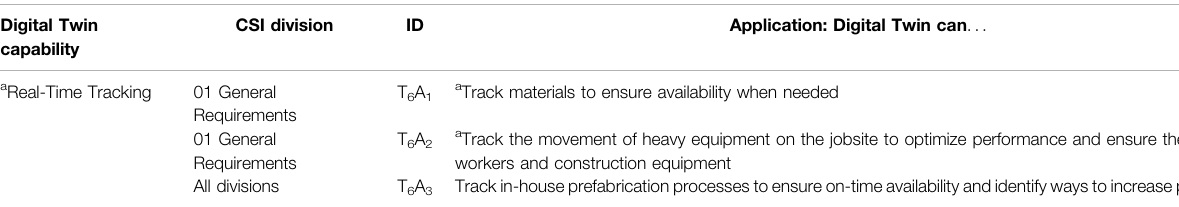
TABLE 8 | Digital Twin capability of Real-Time Tracking and the identi fi ed applications.